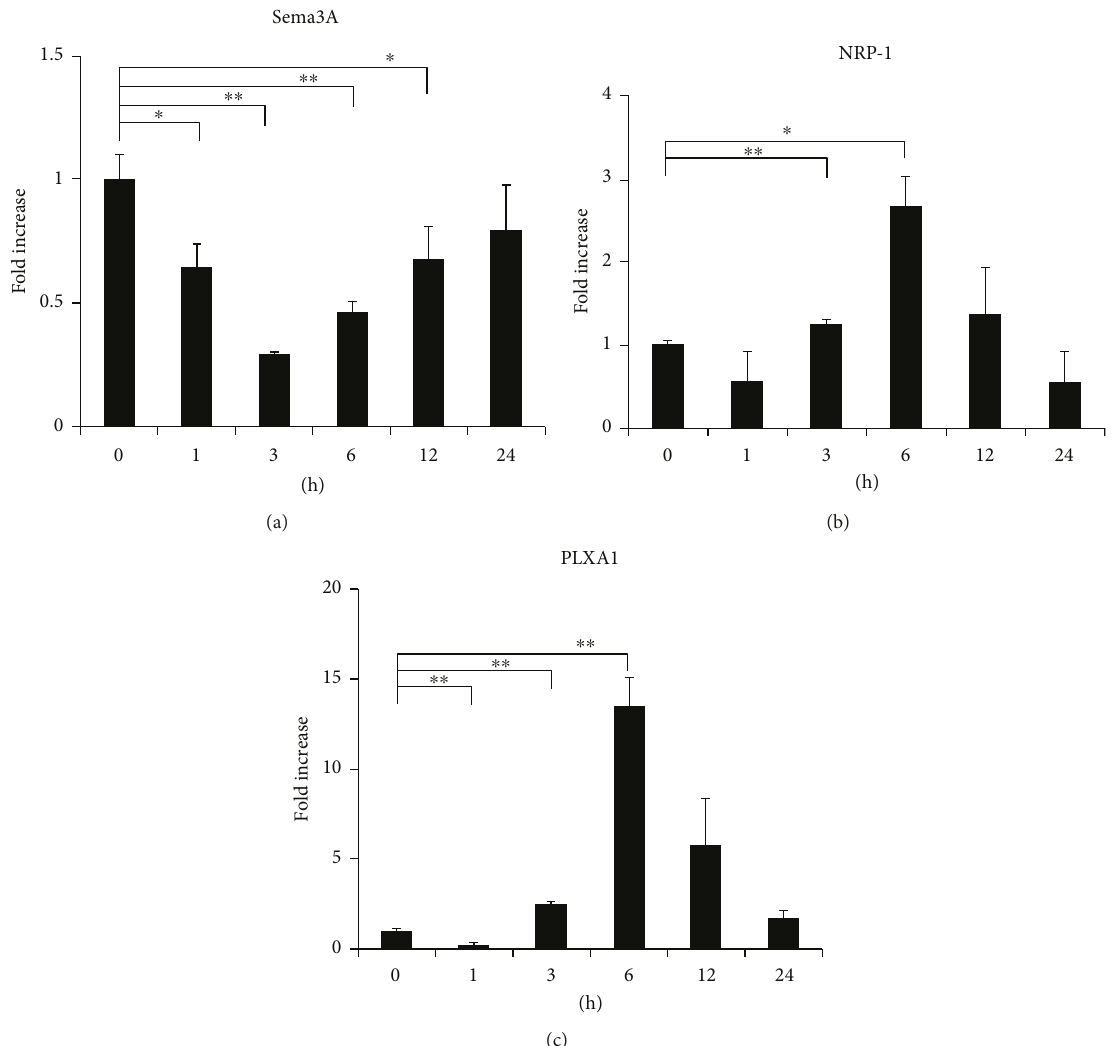
Figure 3: Change in gene expression patterns under excessive mechanical stress. ATDC5 cells were subjected to excessive CTS for 1, 3, 6, 12, or 24 h. Gene expression levels of Sema3A, NRP-1and PLXA1 at each time point were determined by qPCR analysis (a – c). Data are expressed as mean ± SD, n = 3 . ∗ P < 0 05 , ∗∗ P < 0 01 compared to controls at each time